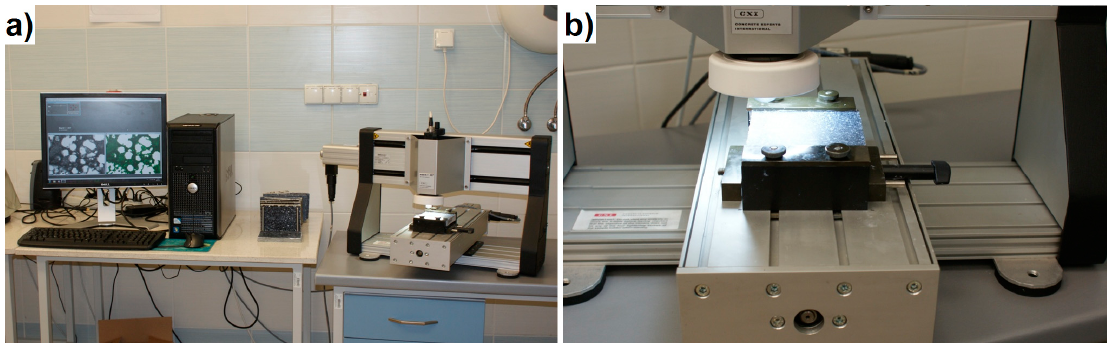
Figure 5. RapidAir 457 device ( a ), specimen during measurement ( b ).